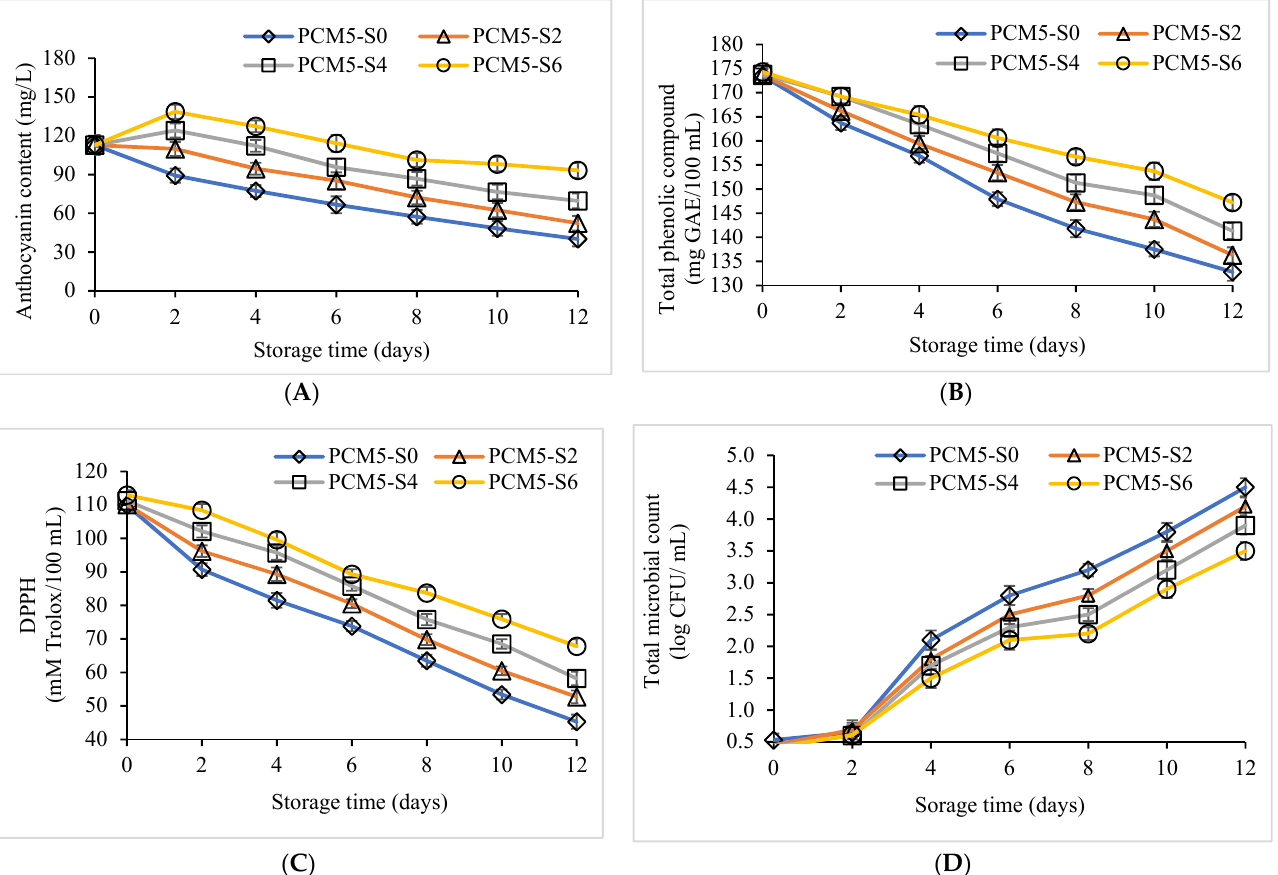
Figure 3. Anthocyanin content ( A ), total phenolic compound ( B ), DPPH ( C ), and total microbial count ( D ) of PCM extracted from 5 min steamed purple corn kernels without and with 0–6% sucrose added during 12 days of storage at 4 °C. Values are presented as mean ± standard deviation ( n = 3). See Figure 2 caption.